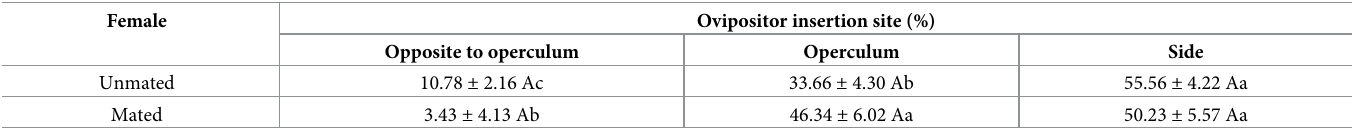
Table 3. Frequency (mean ± standard error) of the ovipositor insertion site per Cleruchoides noackae (Hymenoptera: Mymaridae) unmated or mated female on Thaumastocoris peregrinus (Hemiptera: Thaumastocoridae)